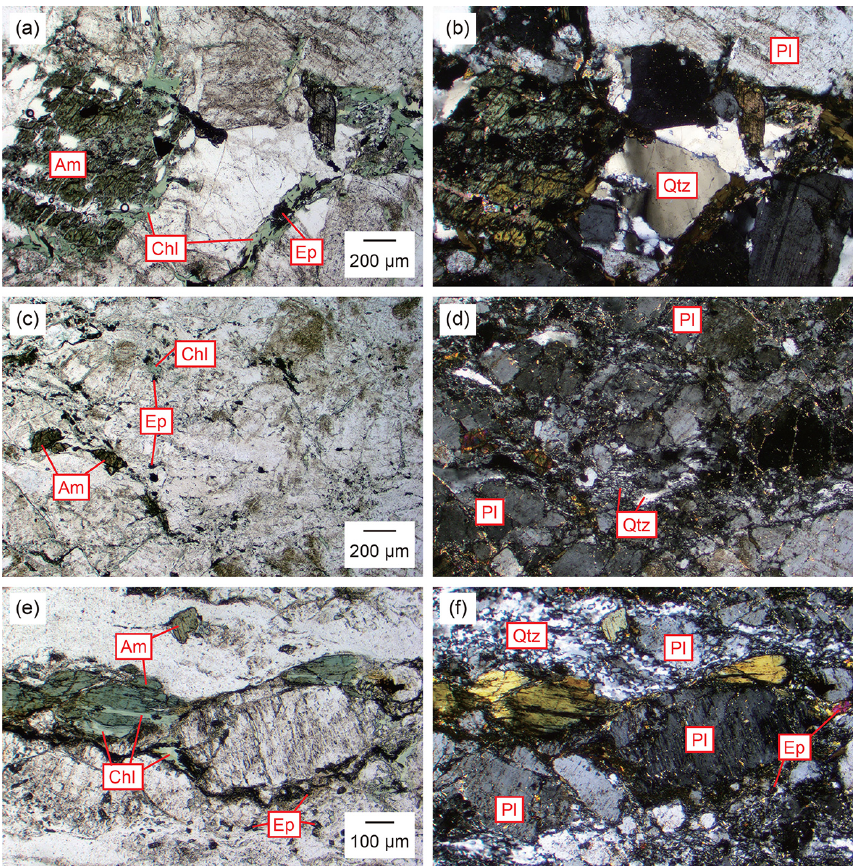
Figure 3. Optical photomicrographs showing microstructures of the Wariyama granite under plane-polarized (a, c, e) and cross-polarized (b, d, f) light. (a, b) Almost-undeformed sample. (c, d) Weakly deformed sample. (e, f) Strongly deformed sample. Microstructures of quartz in the three samples are shown in Fig.